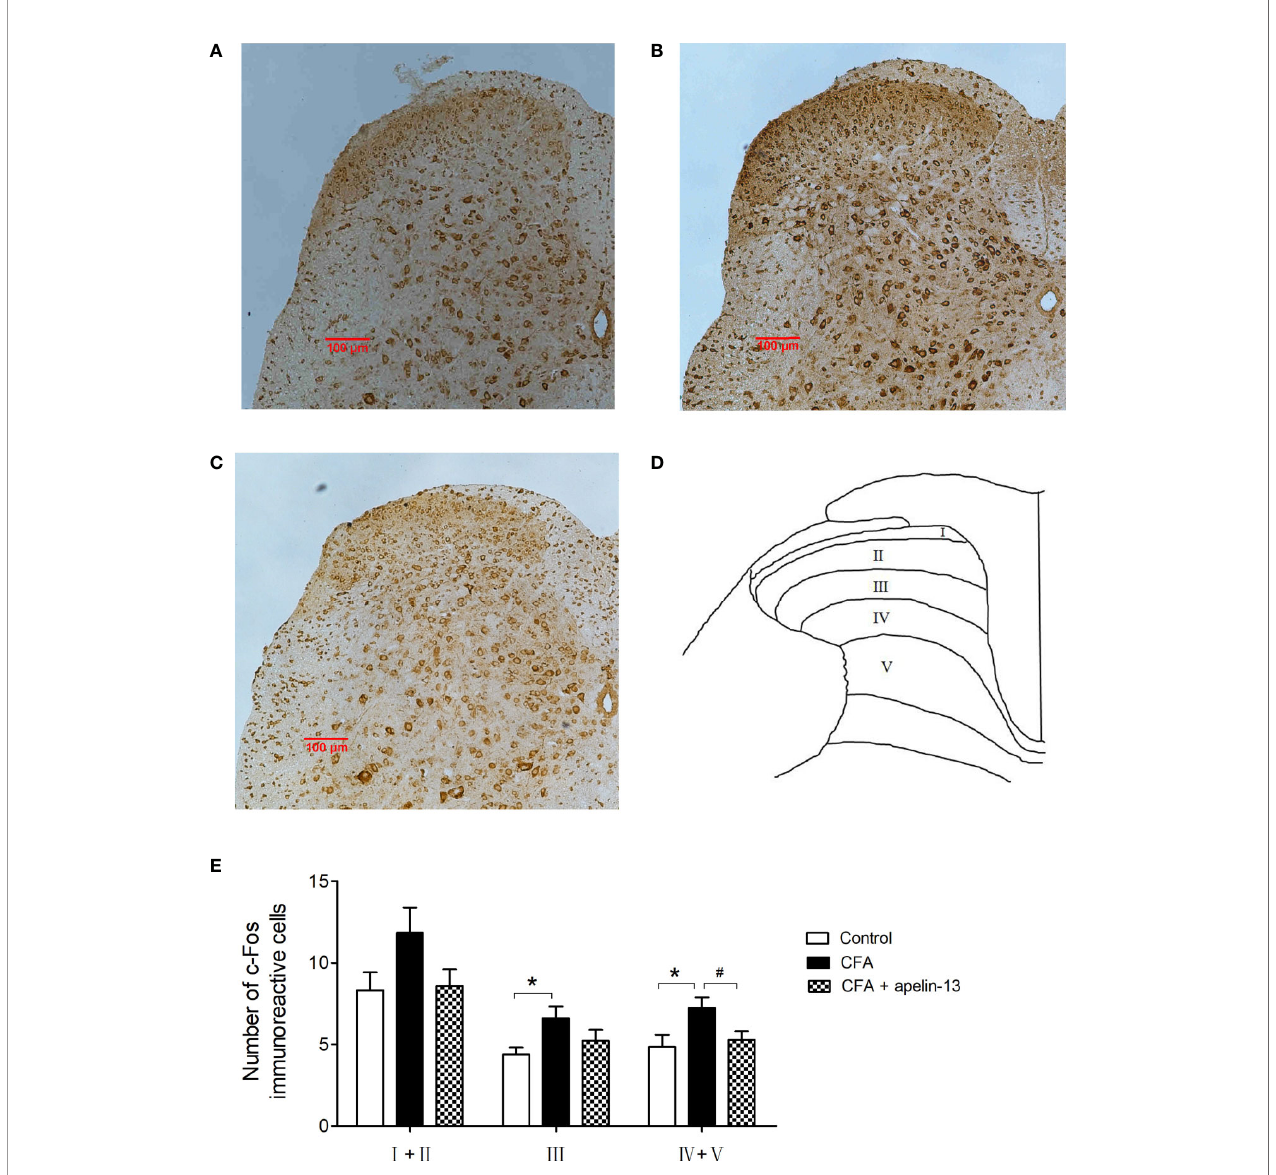
FIGURE 6 | Effect of apelin-13 on Fos protein expression in L4/5 spinal cord in mice. Representative sections of the lumbar spinal cord showing Fos-positive cells in the vehicle control (i.d. NS + i.t. NS, A ), CFA group (i.d. CFA + i.t. NS, B ) and apelin-13-treated group (i.d. CFA + i.t. NS, C ). (D) Objective to measure and evaluate the distribution of Fos-positive cells of the lumbar spinal cord in mice. (E) Quanti fi cation of the number of Fos-positive cells in the spinal cord L4/5 segments from mice. Data are expressed as means ± SEM. * p < 0.05, compared with vehicle control (i.d. NS + i.t. NS); # p < 0.05, compared with CFA group (i.d. NS + i.t. CFA). n = 6 per group. Scale bars = 100 m